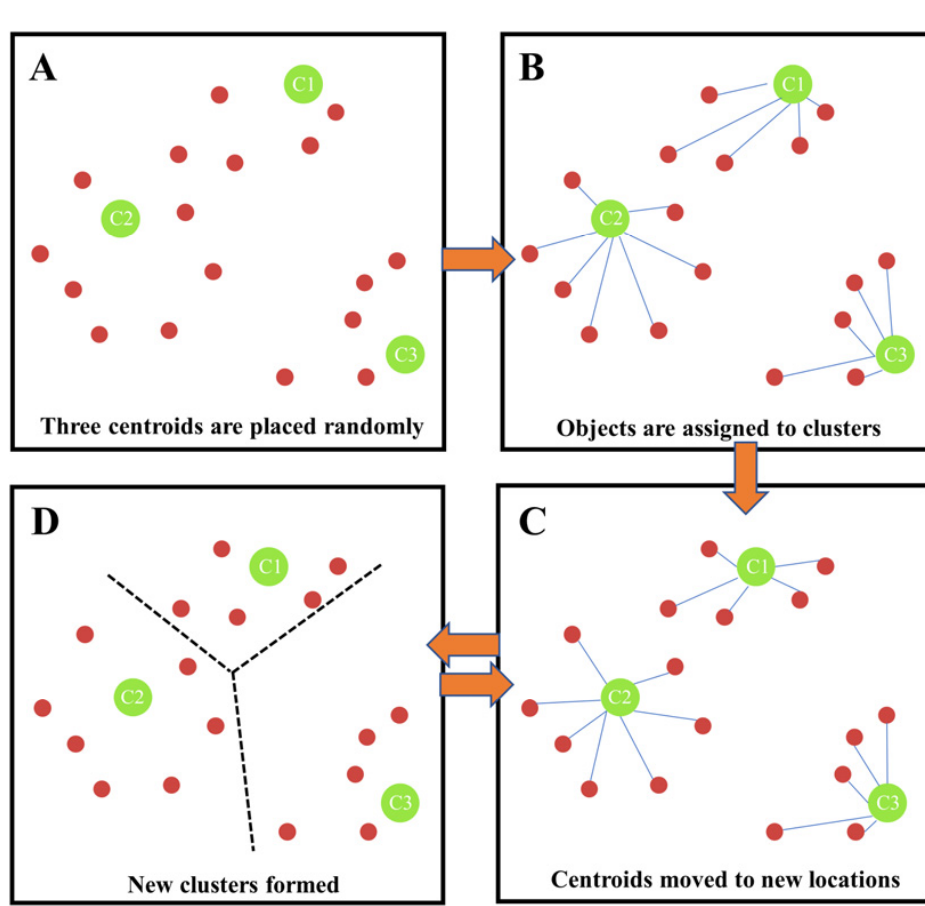
Figure 2. k-means clustering algorithm flow.